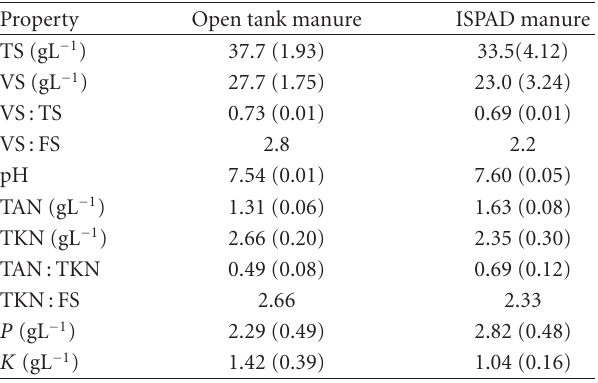
Table 1: Characteristics of experimental manures where both the ISPAD or anaerobically digested manure and the open tank or untreated manure are one year